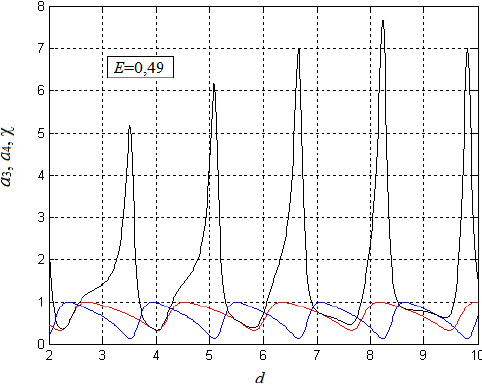
Figure 6: Change in permeability and